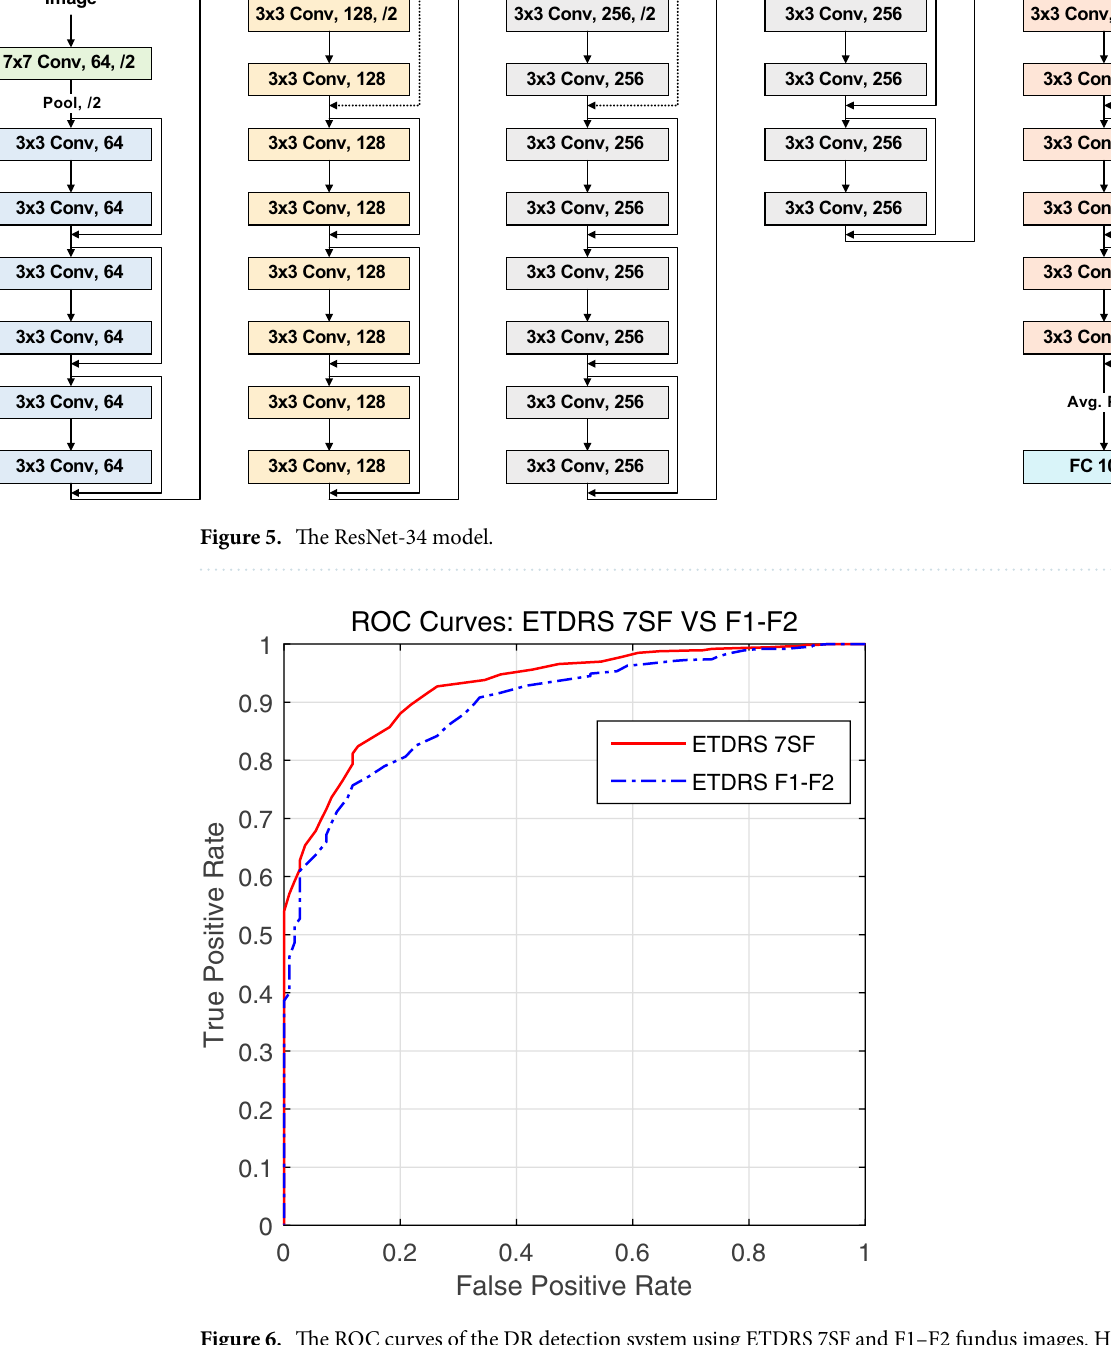
Figure 6. The ROC curves of the DR detection system using ETDRS 7SF and F1–F2 fundus images. Here, we note that the true positive rate and the false positive rate for plotting are obtained from a single running fold experiment among the entire cross-validation